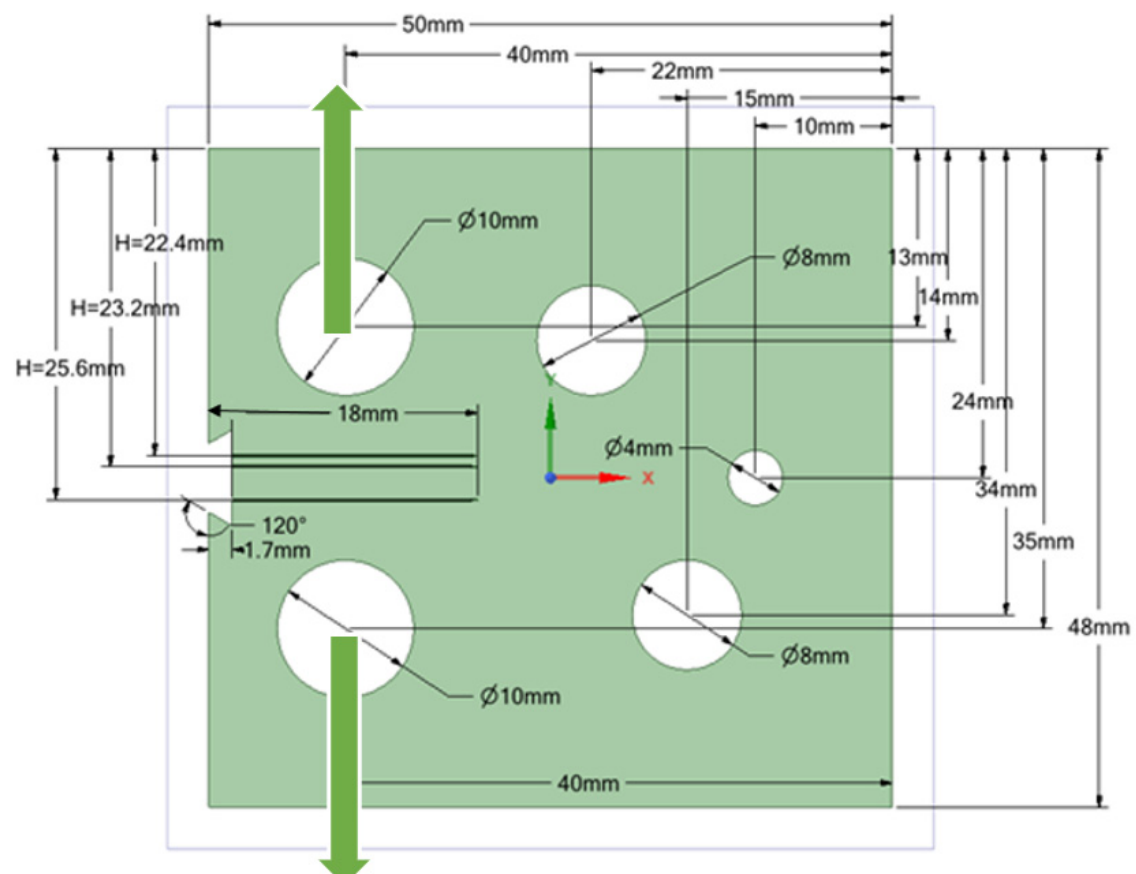
Figure 7. Geometrical dimensions of the Modified Compact tension Specimen ( MCTS) with different initial crack-tip position.